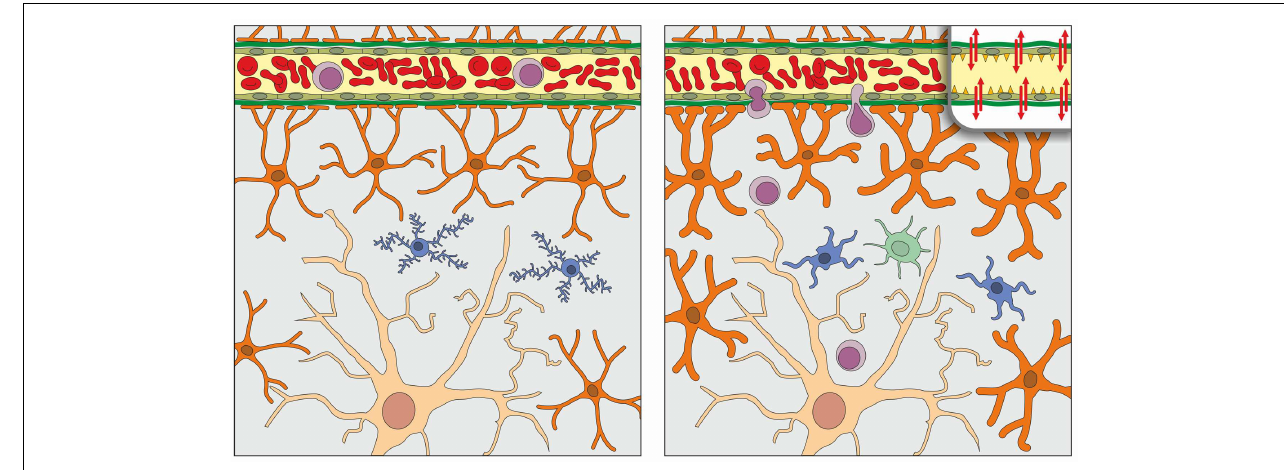
In the aged brain compared to the young brain, astrocytes (depicted as hypertrophic) and microglia (hypertrophic with stout, less ramified processes) show a low grade activation in the steady state; in addition, as shown in the inset (upper right) tight-junctional assemblies between endothelial cells may be altered. At variance with the young brain in which T cell (purple) entry is restricted by the BBB,T cells can infiltrate the aged brain parenchyma in low numbers. Access to dendritic cells (one dendritic cell is shown in light green) may also be facilitated in the aged brain. Adapted and modified from Bentivoglio et al.